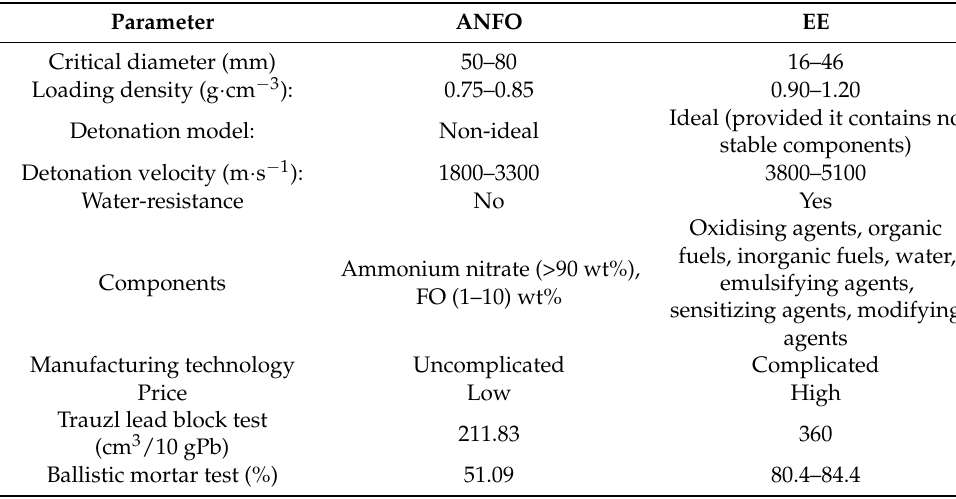
Table 2. Comparison of energetic properties of typical ANFO and EE formulations [17–20]. Parameter ANFO EE Critical diameter